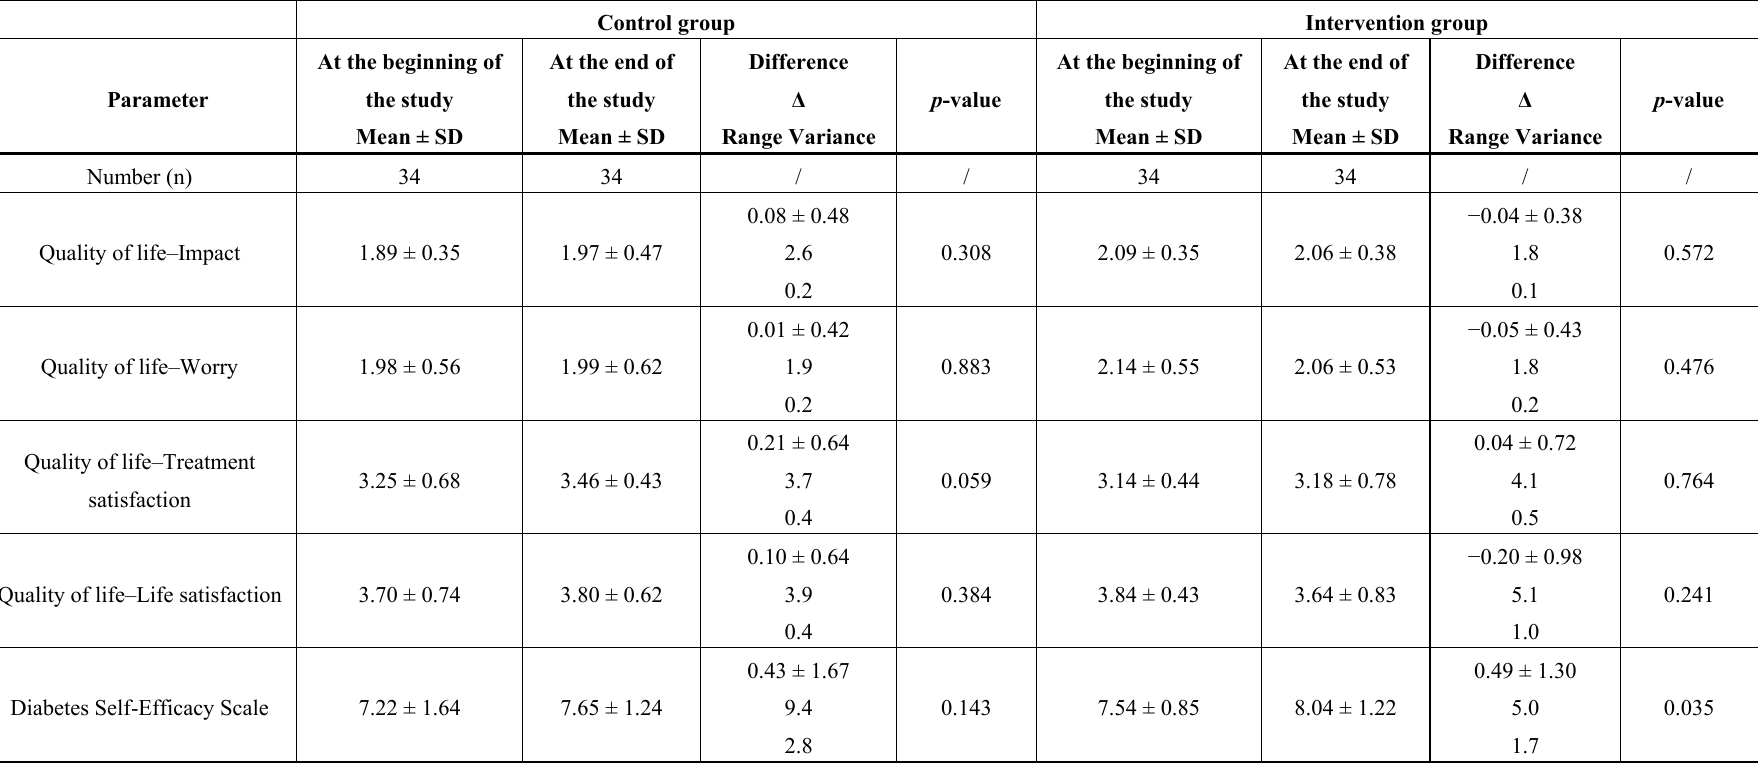
Table 3. Changes in psychological parameters during the study (pairwise [intra-individual] comparison at beginning vs. at the end of the study), control and intervention groups ( n = 68 subjects with type-1 diabetes